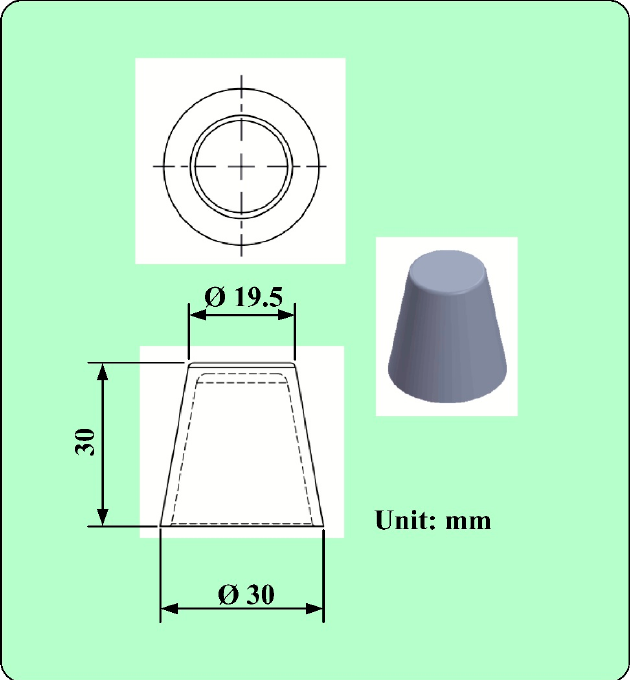
Figure 2. 3D CAD model of the wax pattern.